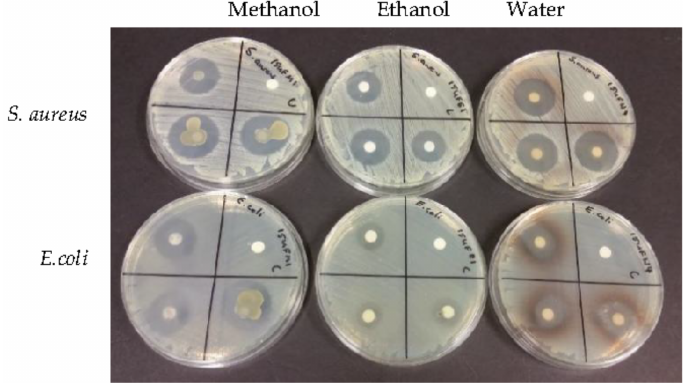
Figure 1. Disc diffusion assay of flesh against top row, S. aureus and bottom row E. coli , from left to right extracts are methanol, ethanol and water, with controls in top right hand corner of plates. n =